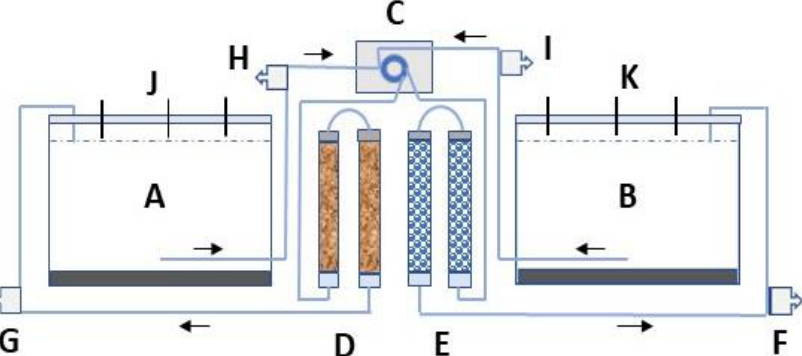
Figure 1. Schematic presentation (not to scale) of the experimental set-up. Hypolimnetic water was pumped ( C ) from container ( A ) to two series-connected columns ( D ) filled with Polonite and back to the water surface. An identical procedure was performed with container B , but the water was pumped ( C ) through columns filled with glass beads ( E ). Openings in the lid ( J , K ) were used for sampling of water, in situ measurements of physical parameters, and supply of N 2 . ( F – I ) indicate ports for sampling column influent water and column effluent water, respectively. The water in the containers was measured randomly at three depths: 5 cm below water surface, 15 cm below, and at 23 cm depth, just above the sediment surface. The 10 cm thick layer of sediment is marked in black.